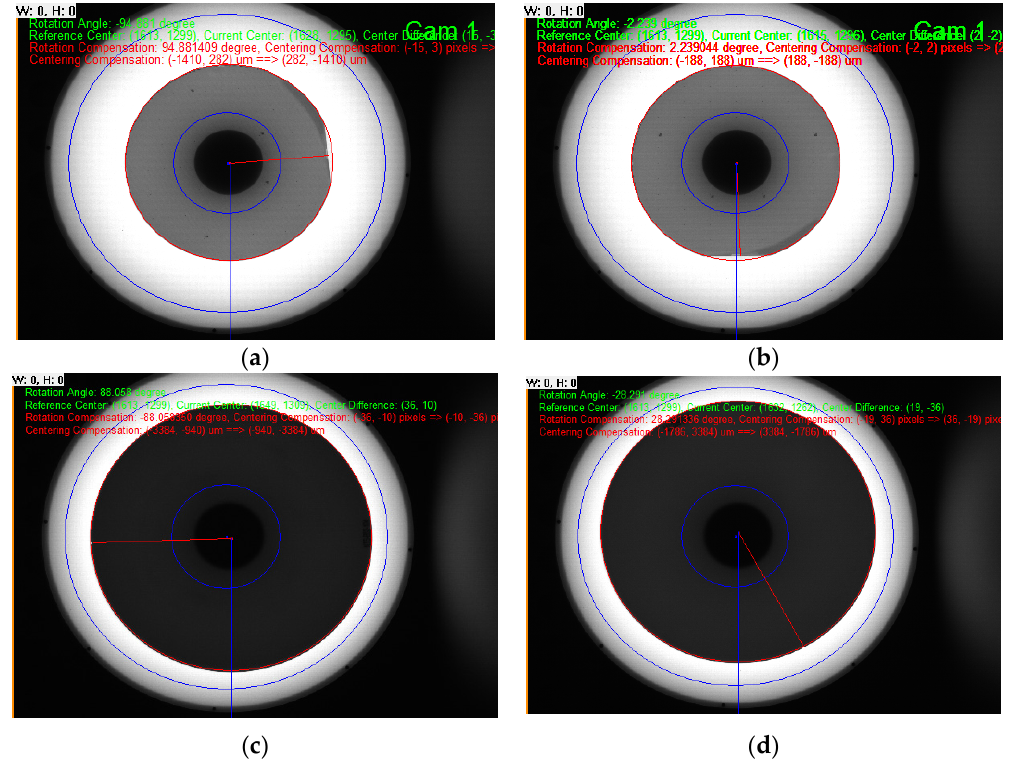
Figure 8. Position and angle correction with Cam 1, ( a ) before the operation (wafer/flat type); ( b ) after